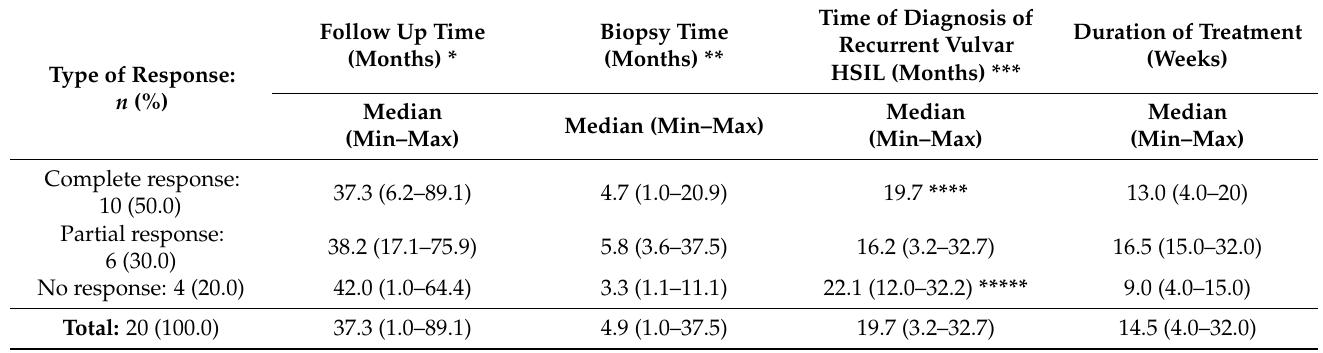
Table 3. Follow up time, biopsy time post imiquimod, and time of diagnosis of recurrent vulvar HSIL in patients with complete, partial and no response to treatment with